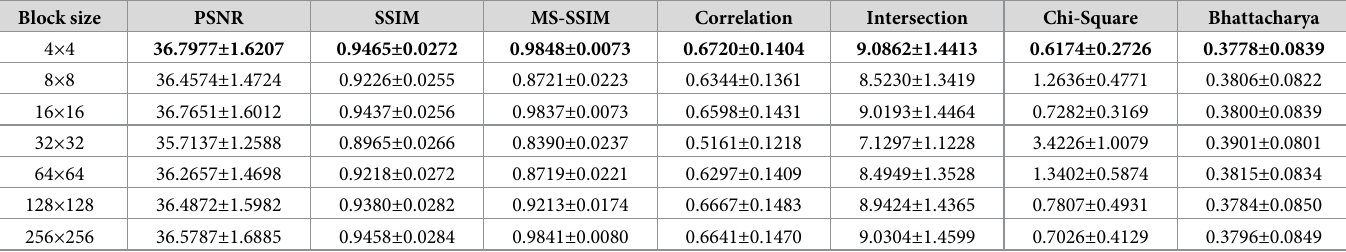
Table 3. Performance achieved by the DeBoNet using various sizes for the sub-blocks. The values are given in terms of mean ± standard deviation. The best perfor- mances are denoted by bold numerical values in the corresponding columns. Block size PSNR SSIM MS-SSIM Correlation Intersection Chi-Square Bhattacharya